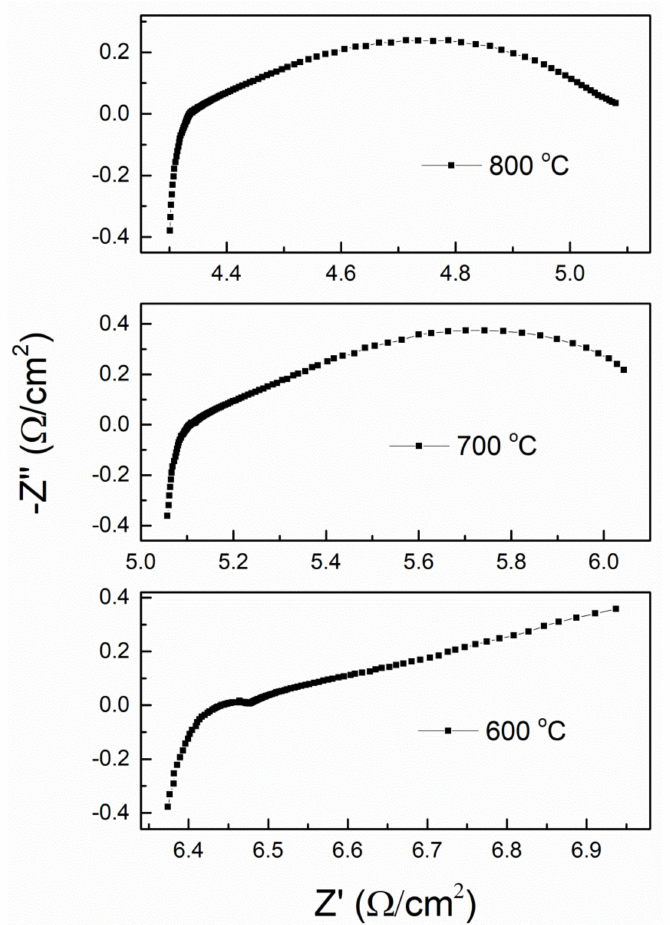
Figure 8. Complex impedance spectra of the LSM // LSGM